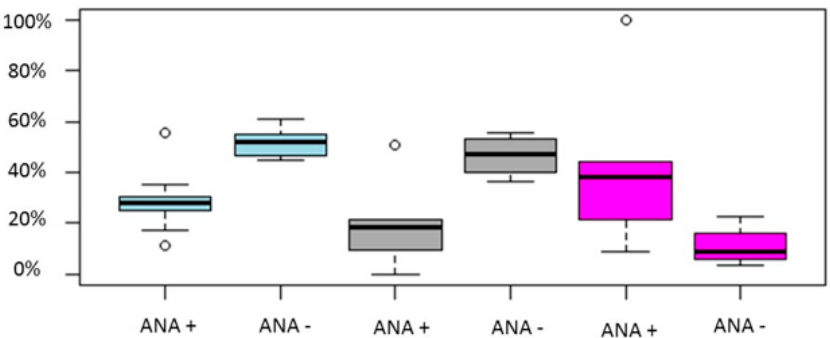
Figure 4. Boxplot regarding CP, LB/OP and miscarriage rates between ANA positive and ANA negative women. Blue color represents CP rate, grey LB/OP rate and magenta represents miscarriage rates. Circles in the figure represent outliers -values outside the 1.5x interquartile range.